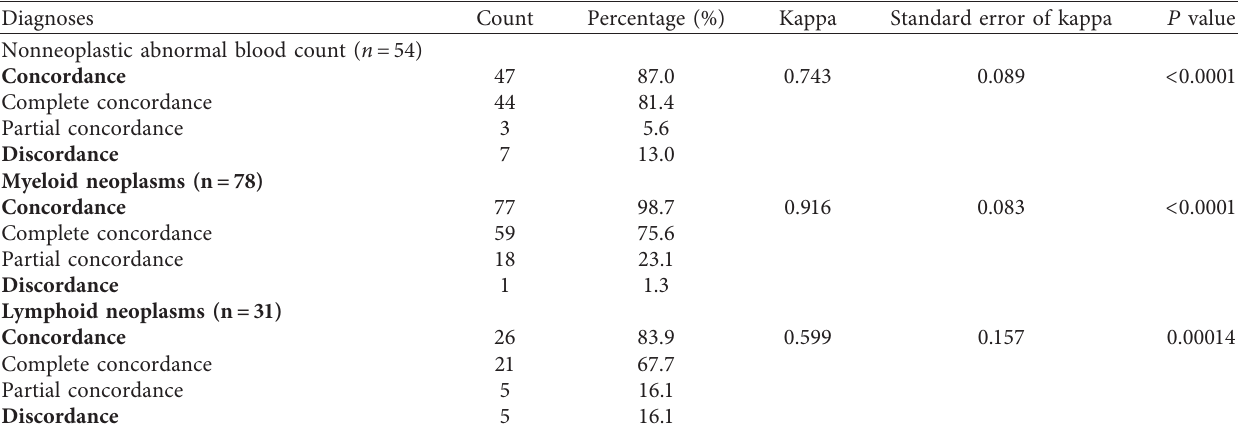
Table 3: Correlation of NGS result between peripheral blood and bone marrow NGS grouped by diagnostic